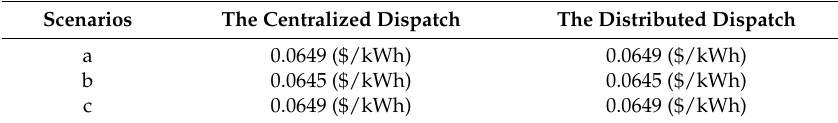
Table 4. VPP’s average profits made by the two dispatch strategies. Scenarios